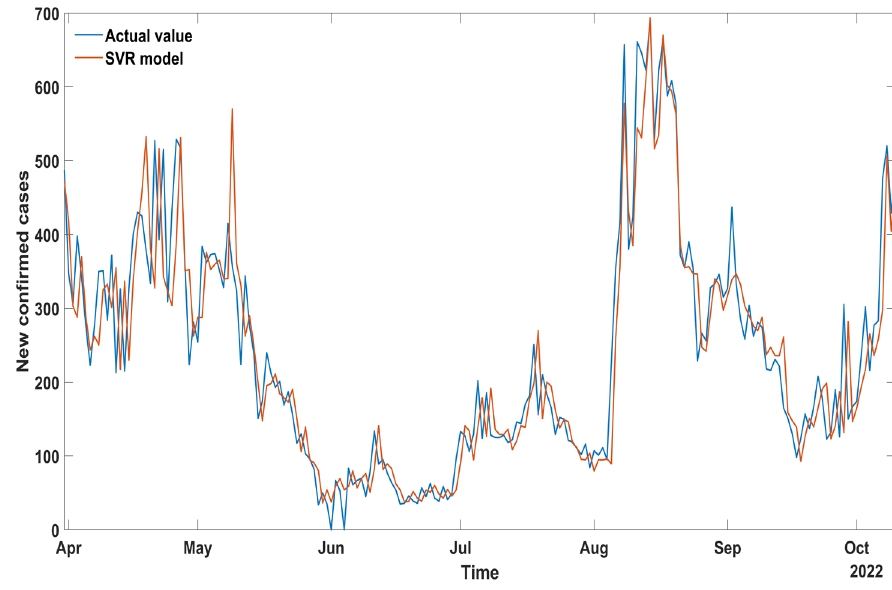
Figure 6. Comparison of the SVR model and the true value.